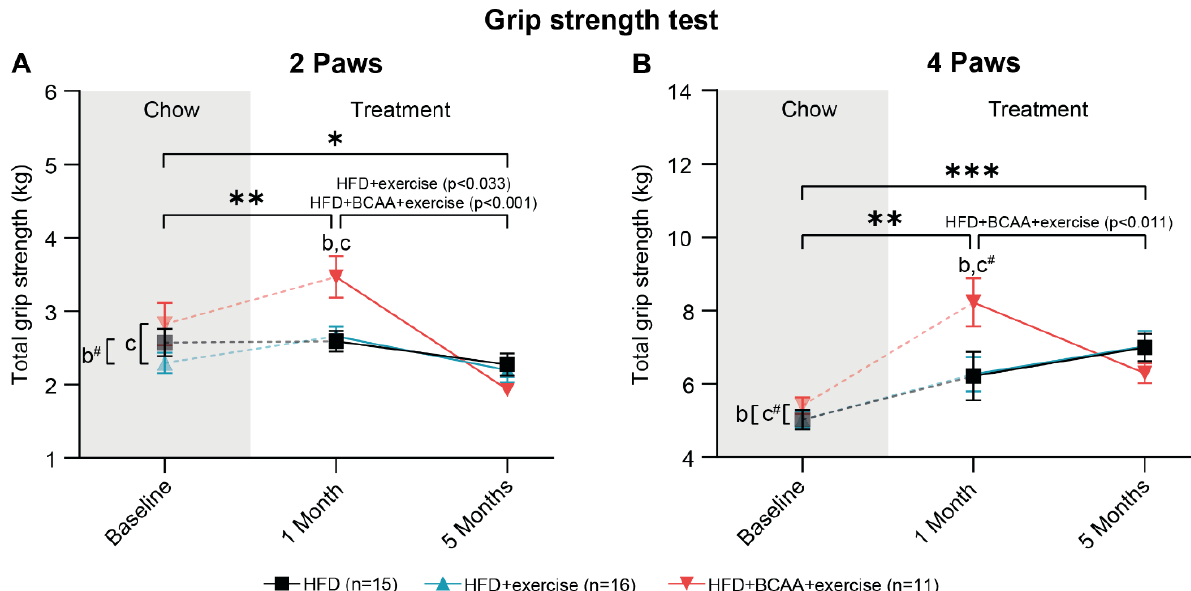
Figure 5. Grip strength test. Total muscle strength of ( A ) forelimbs (2 paws) and ( B ) fore- and hindlimbs combined (4 paws), was measured at baseline (chow) and after 1 and 5 months of treatment with exercise and exercise combined with BCAA supplementation. High-fat diet (HFD), branched-chain amino acids (BCAA). Data are presented as mean ± SEM. * p < 0.05, ** p < 0.01, *** p < 0.001, # 0.05 < p < 0.08 (trend); b: significant difference HFD vs. HFD + BCAA + exercise group, c: significant difference HFD + exercise vs. HFD + BCAA + exercise group.